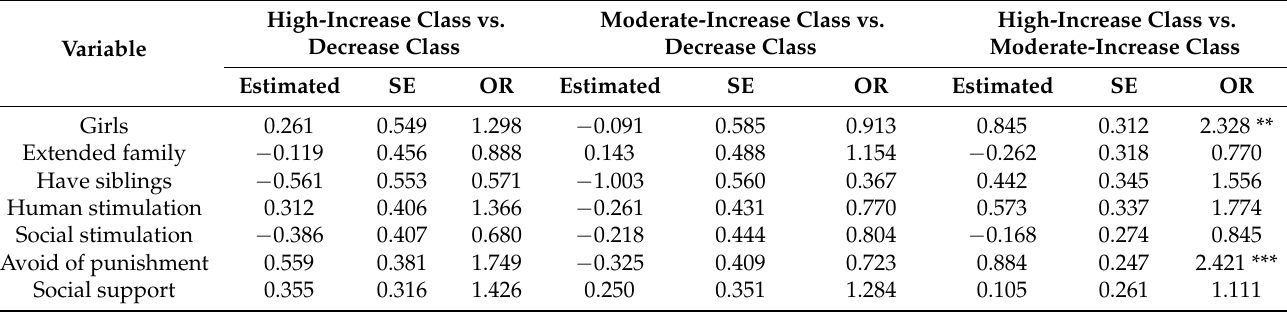
Table 4. Conditional latent class growth